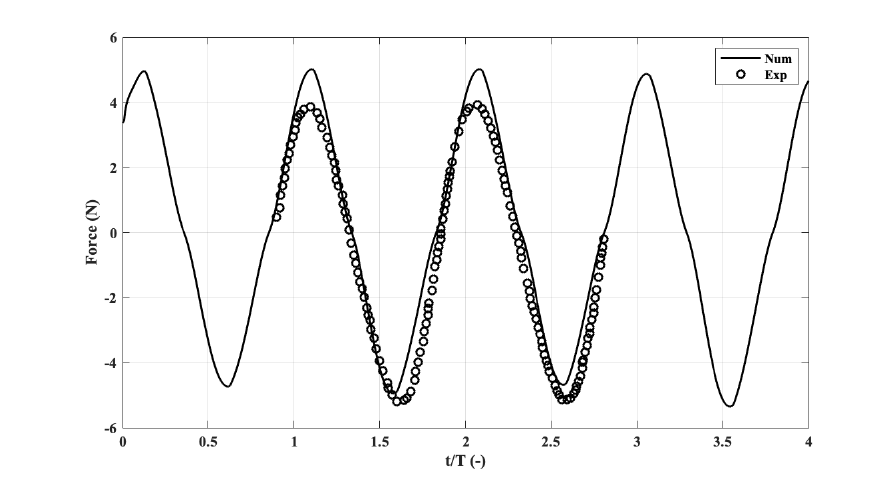
Figure 4. Comparison of the numerically predicted and measured [1] time series of the drag forces on net panels in waves with different wave height.